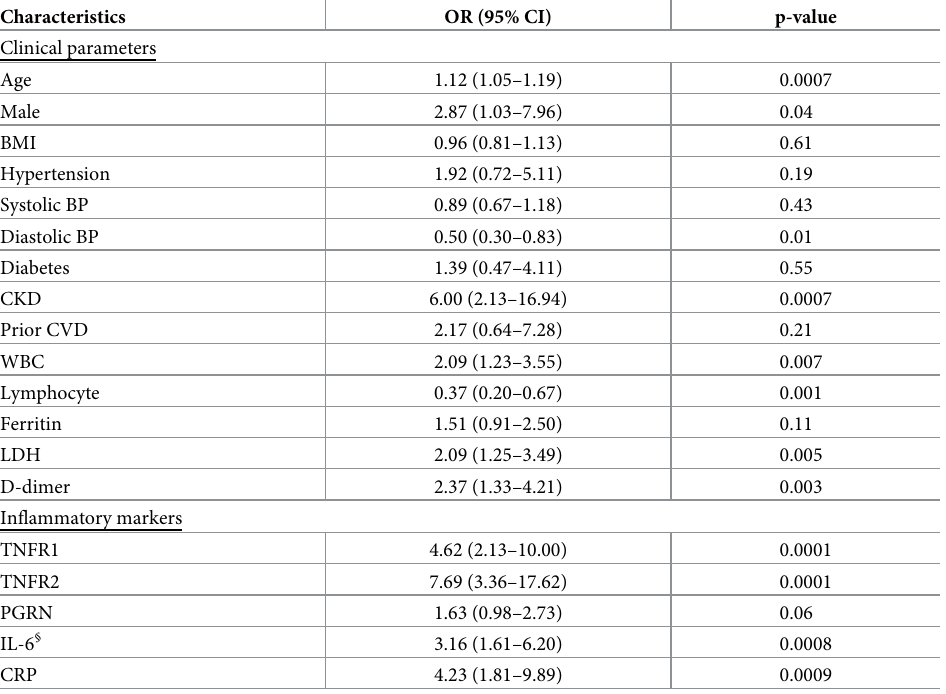
Table 4. Results of univariate logistic regression analysis of the clinical parameters and inflammatory markers for mortality.